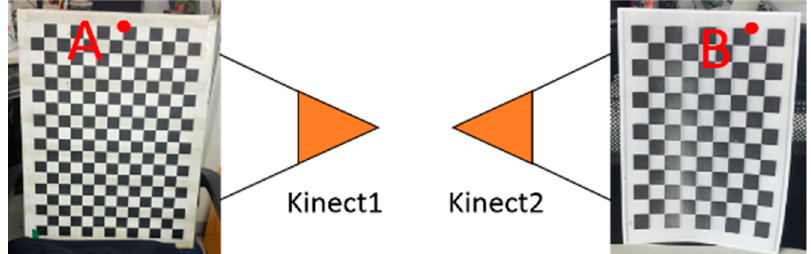
Figure 3. The placement of the two calibration boards in the two-Kinect extrinsic calibration accuracy experiment. A and B are the two corner points to be measured distance. Table 1. Accuracy comparison among three extrinsic calibration methods Sequence